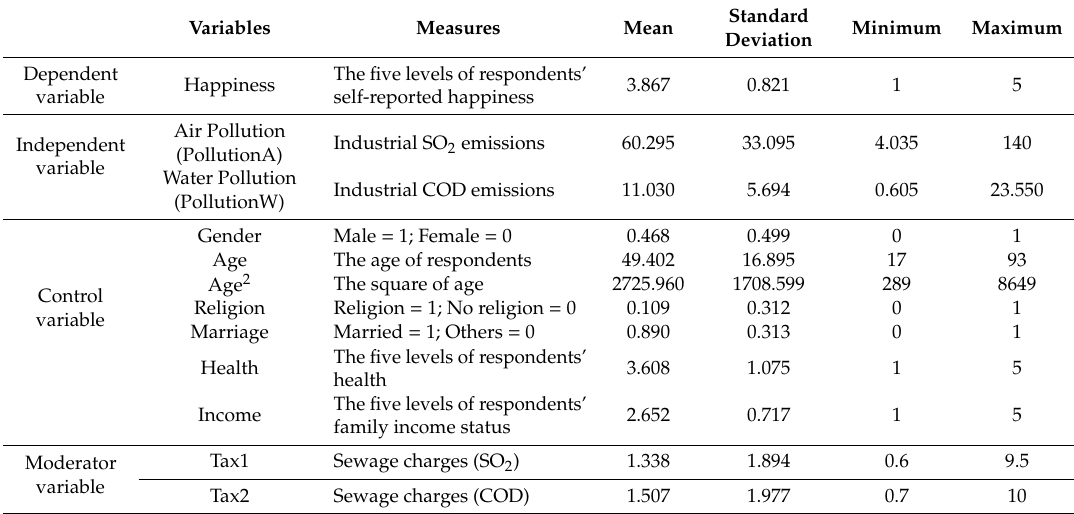
Table 2. Descriptive